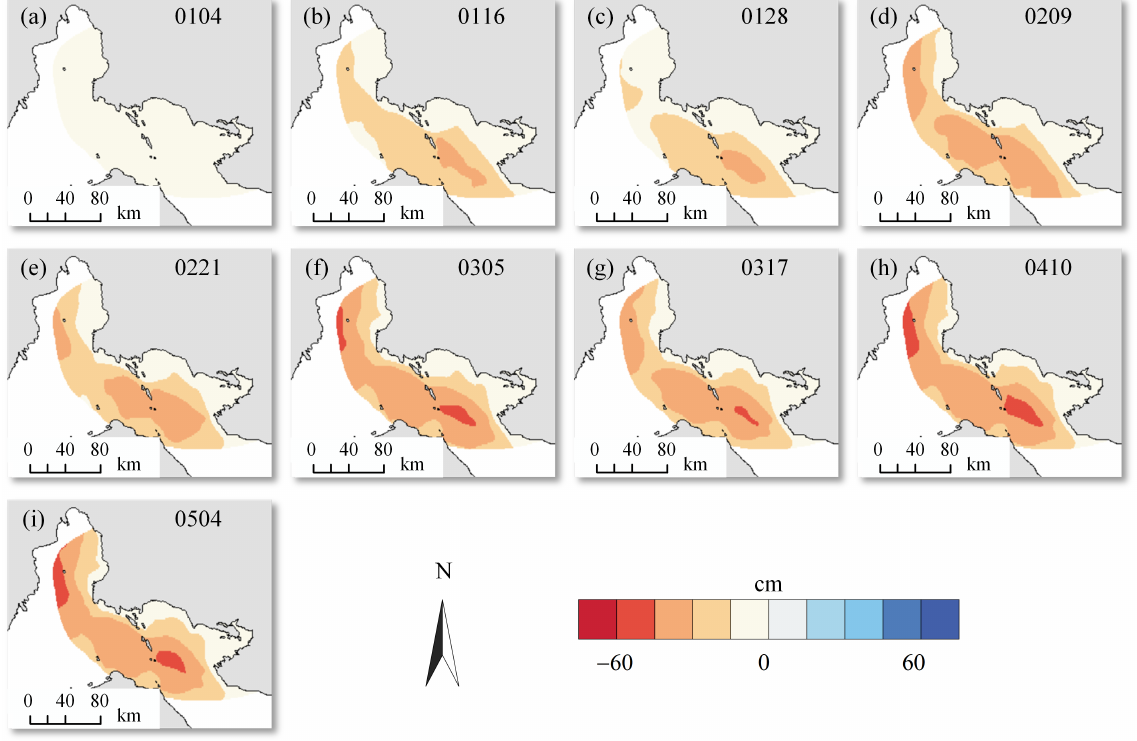
Figure 9. Retrieved time-series vertical deformation from January 2019 to May 2019: the top-right number of subfigures ( a – i ) represents the corresponding SAR images acquisition